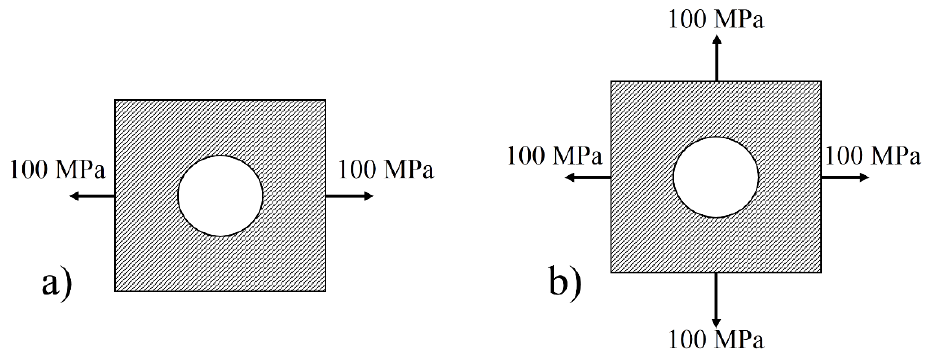
Figure 4. Boundary conditions for each loading case ( a ) Uniaxial loadings ( b ) Multiaxial loadings .